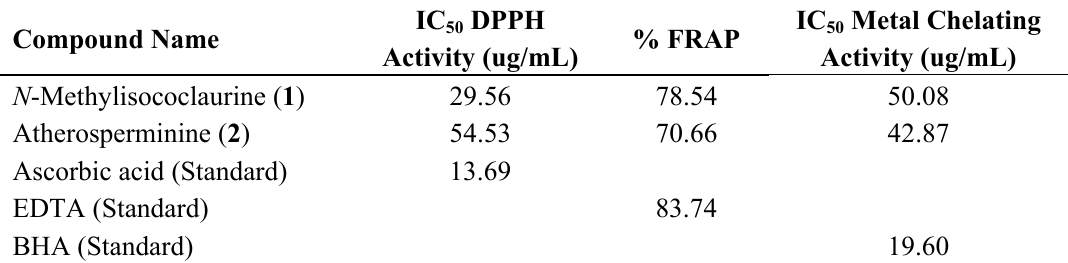
Table 2. Antioxidant Activities of Alkaloids from Cryptocarya nigra